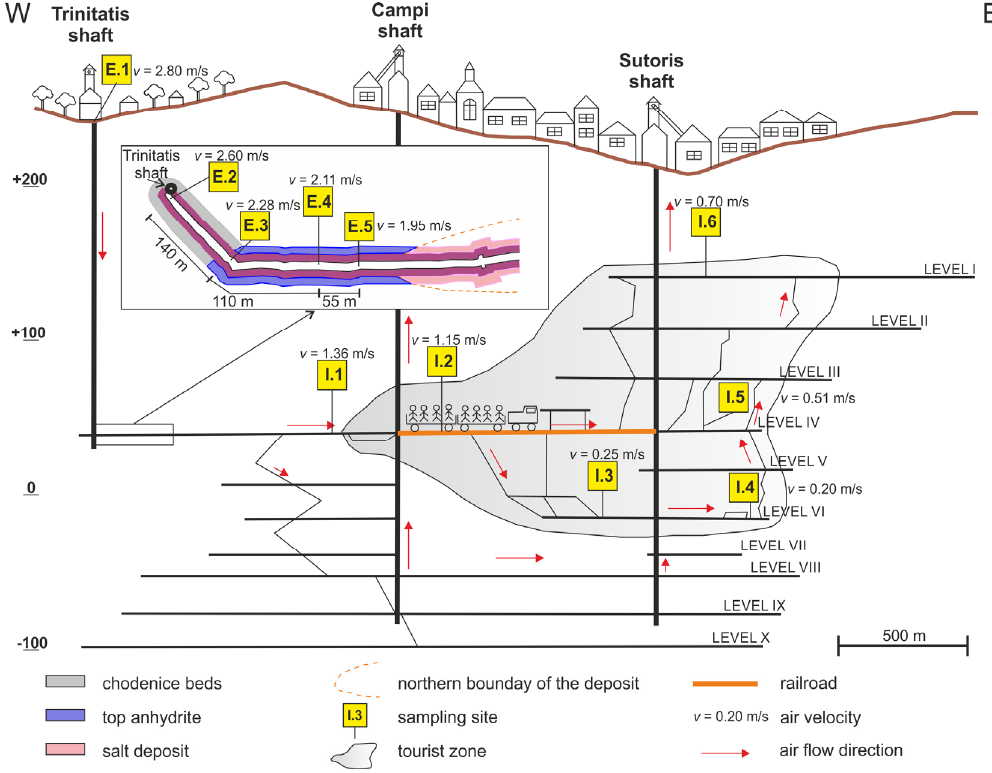
Figure 2. Location of the sampling sites in relation to airflow directions on a schematic longitudinal section of Bochnia Salt Mine.